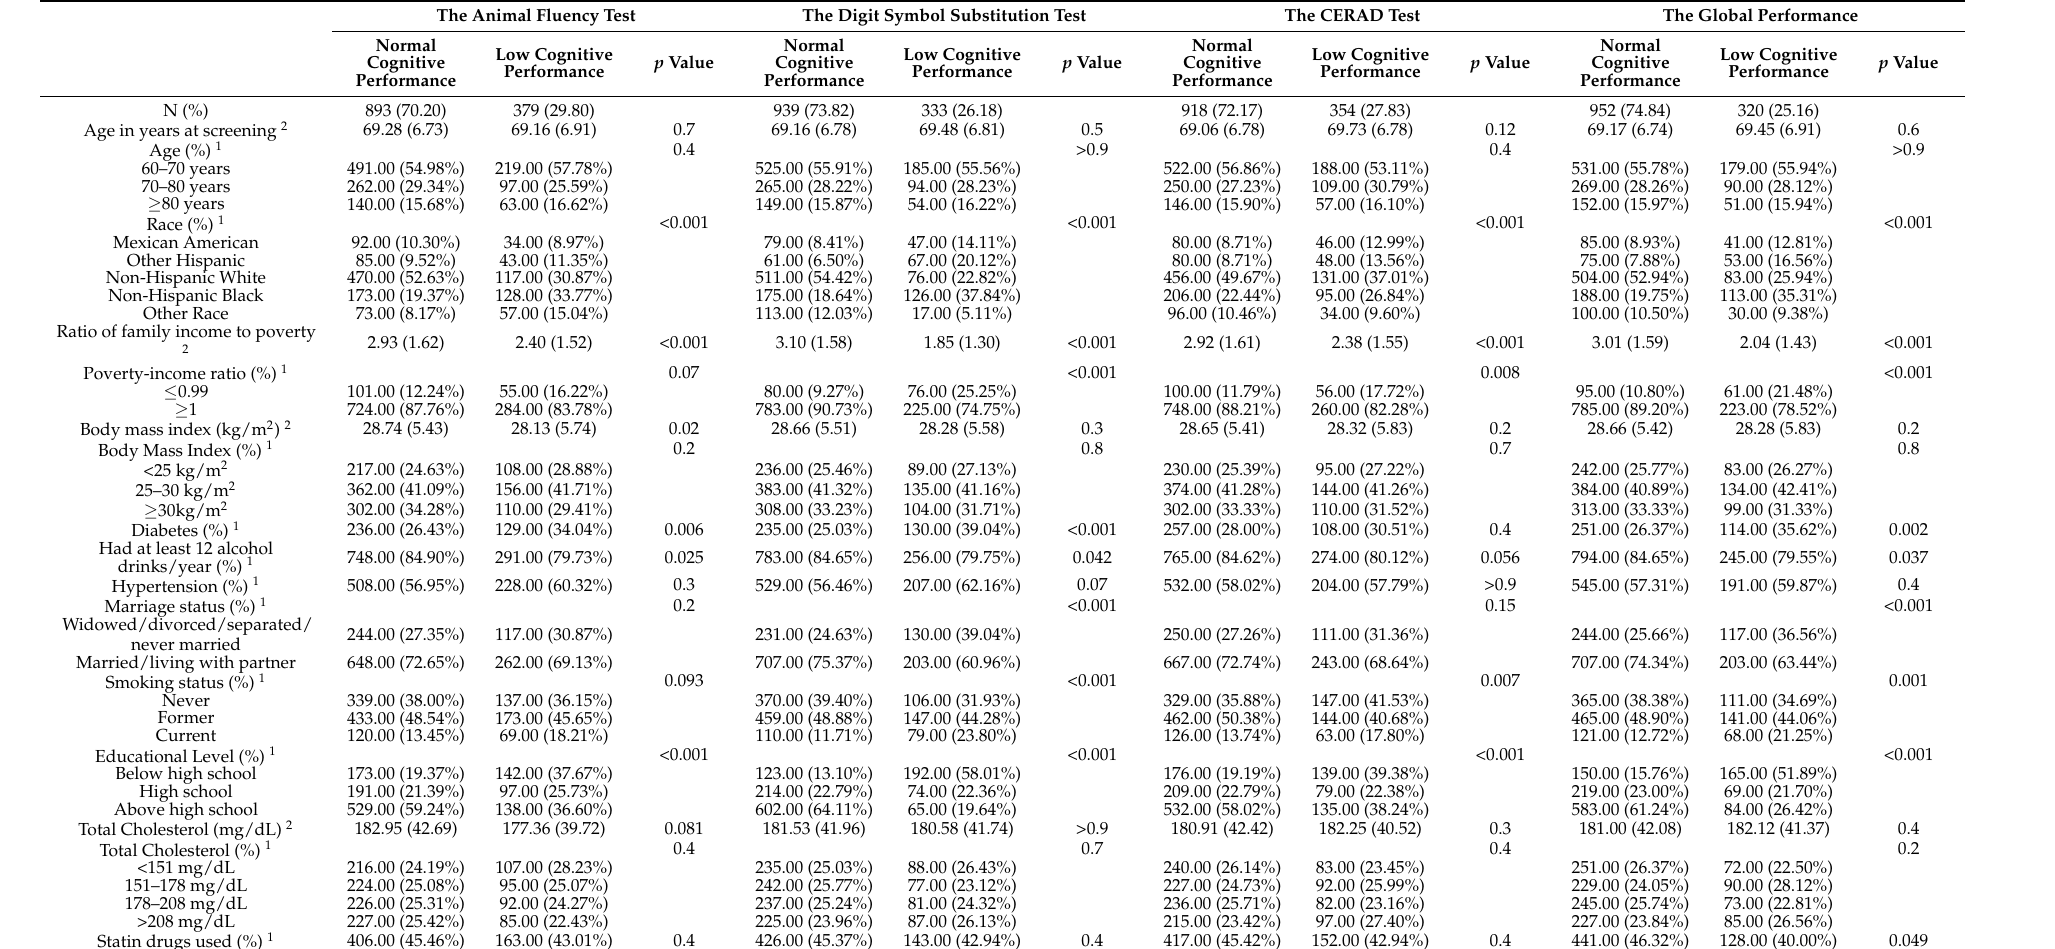
Table 3. Characteristics of the male population ( N =